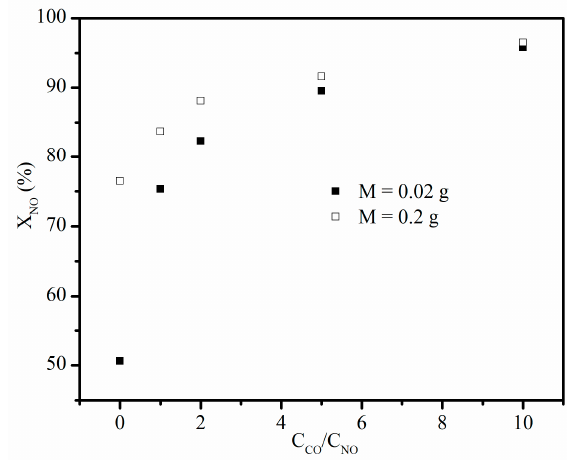
ff ect of char loading on NO reduction with rice husk Figure 6. Effect of char loading on NO reduction with rice husk char. Figure 6. E Figure 6. Effect of char loading on NO reduction with rice husk char.